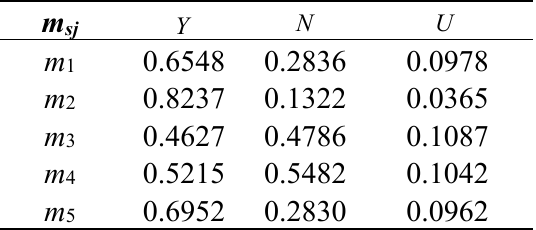
Table 8. The accumulation of basic probability values by five sensors with three